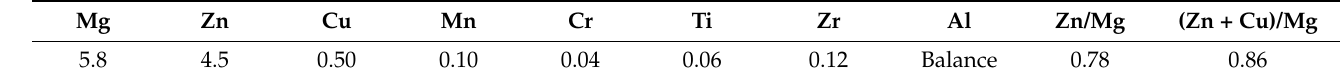
Table 1. The nominal chemical composition of Al-5.8Mg-4.5Zn-0.5Cu alloy